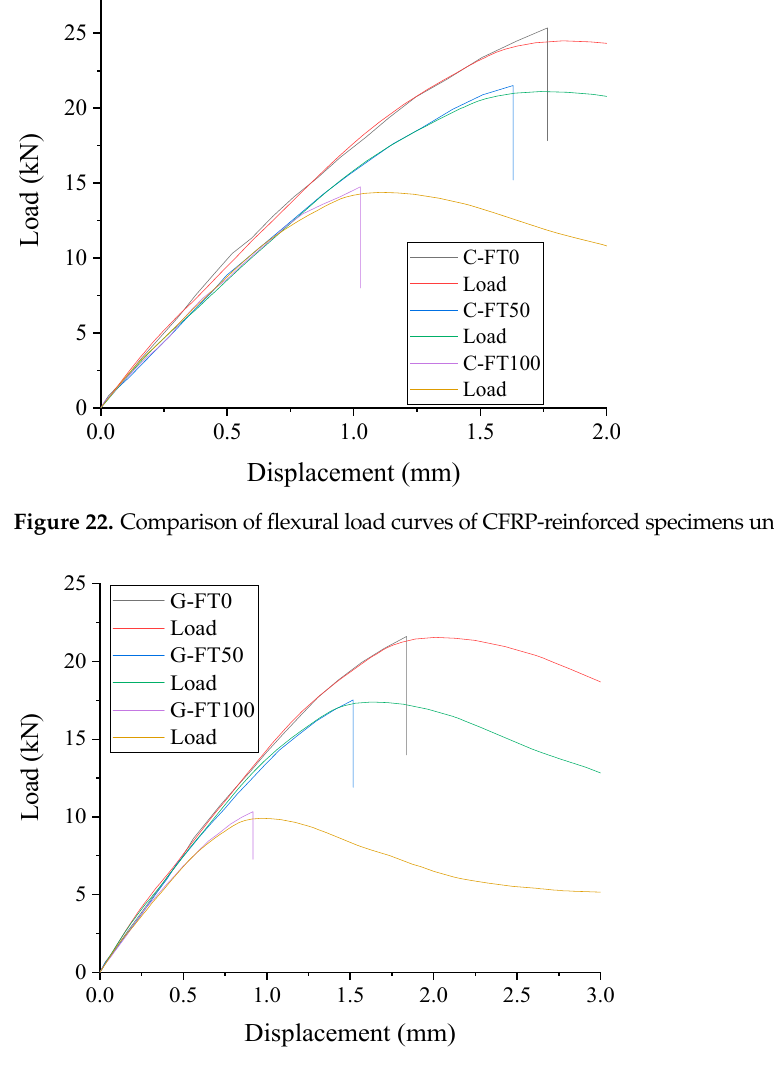
Figure 23. Comparison of flexural load curves of GFRP-reinforced specimens under freeze-thaw